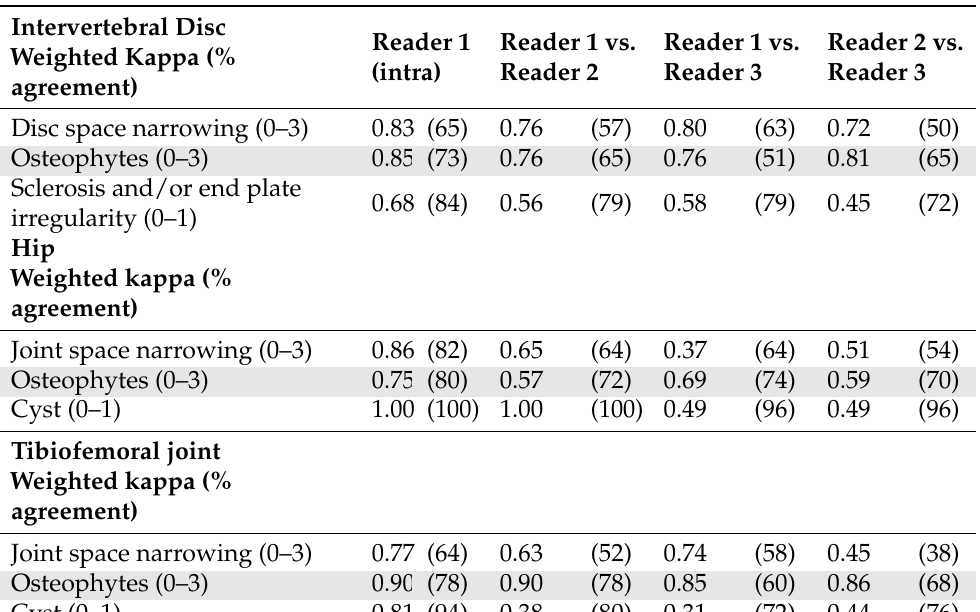
Table A1. Intra- and interobserver reliability for grading of individual